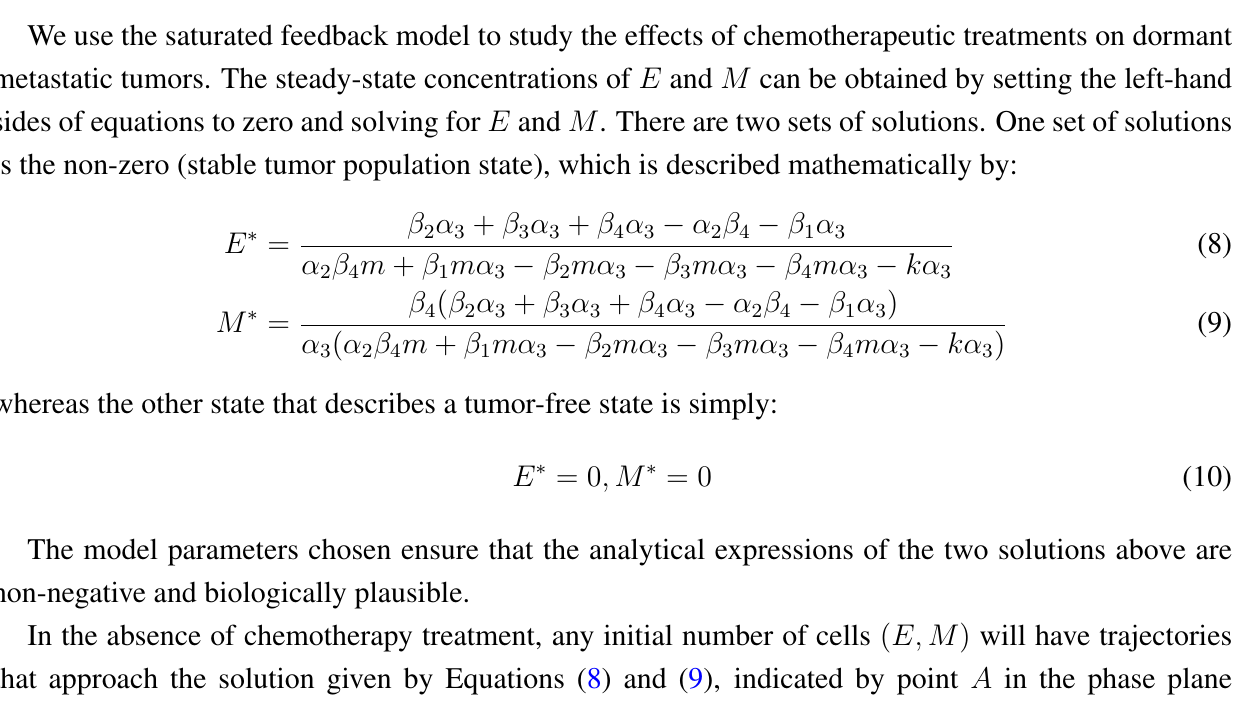
(the rate of EMT) 4